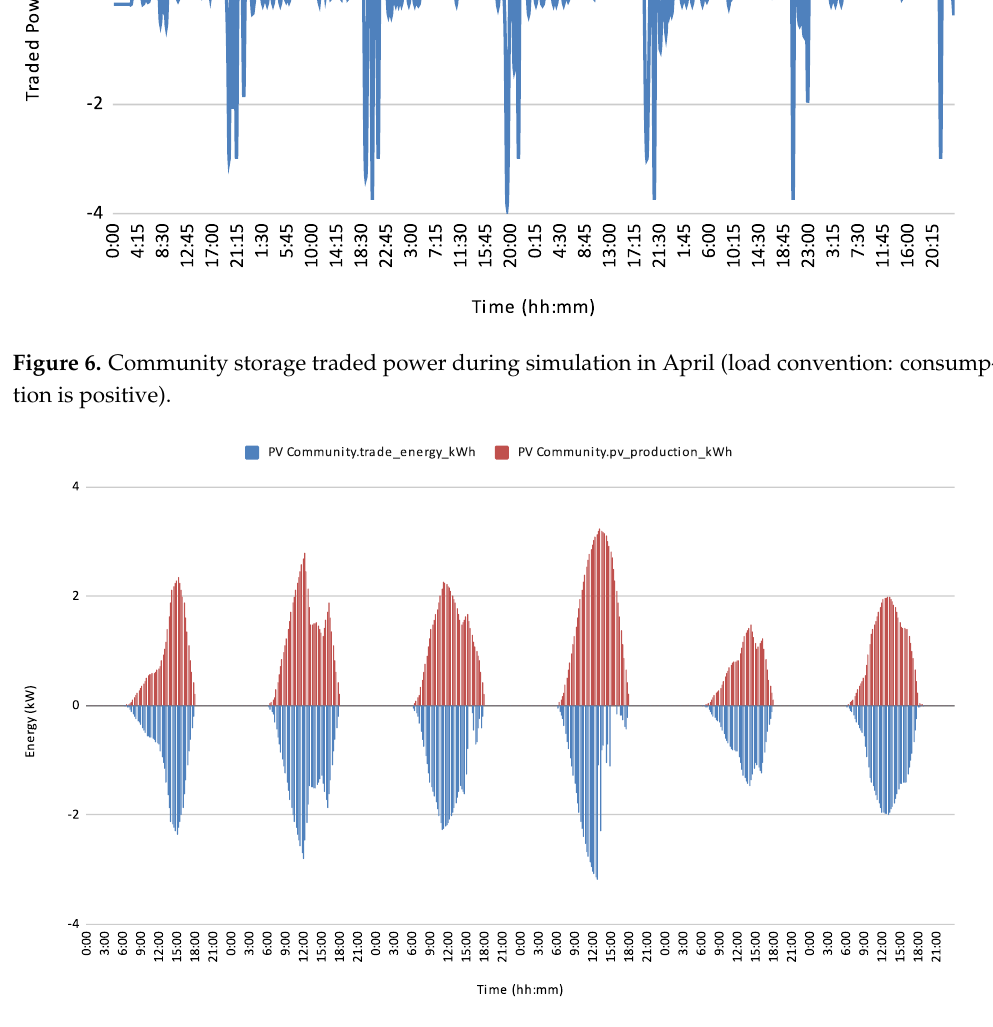
Figure 7. Community PV produced and sold power during simulation in April (generated power is positive, sold power is